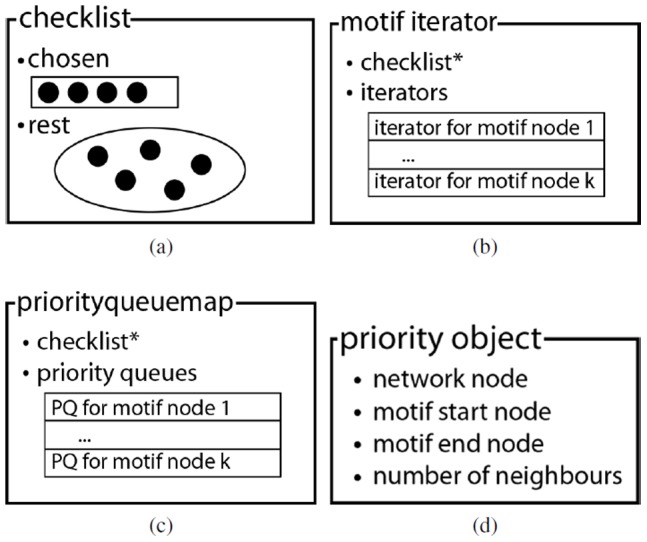
Data Structures.(a) The checklist. In the ISMA algorithm, the circles represent motif nodes (b) The motif iterator. (c) The priority queue map. (d) The priority object. It is assumed that the motif has k nodes.